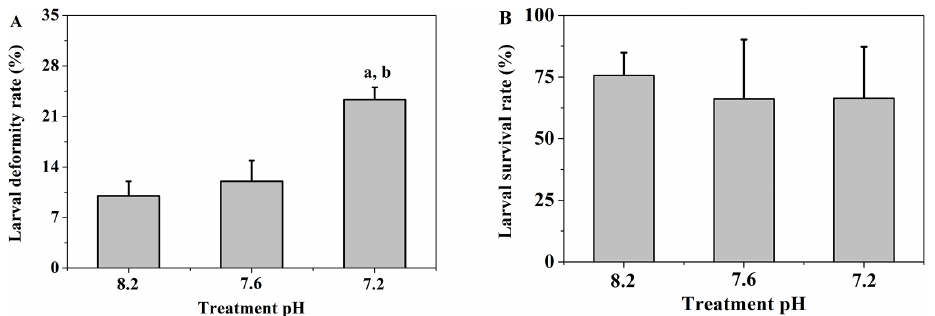
Figure 4. The deformity and survival rates of larvae exposed to three pHlevels. (a) Deformity rate; (b) survival rate. (a) indicates that the value in pH7.2 or in pH7.6 differs significantly from that in the control (pH8.2), and (b) indicates that the value in pH7.2 differs significantly from that in